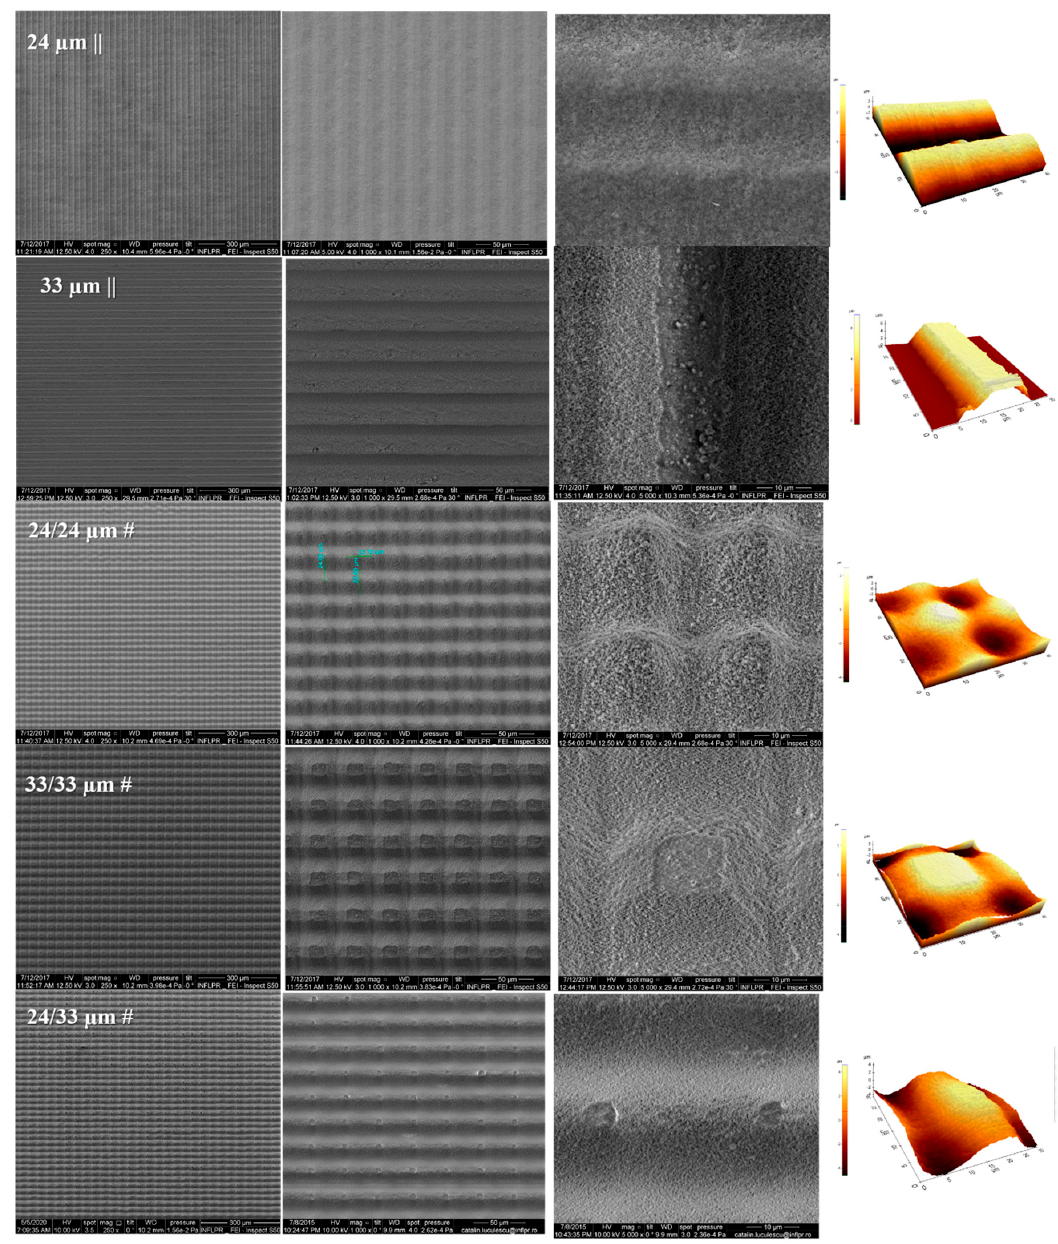
Figure 2. Scanning electron microscopy (SEM) and atomic force microscopy (AFM) images of isotropic (24 µm || and 33 µm ||) and anisotropic textured surfaces structures (24/24 µm#, 33/33 µm #, and 24/33 µm #).